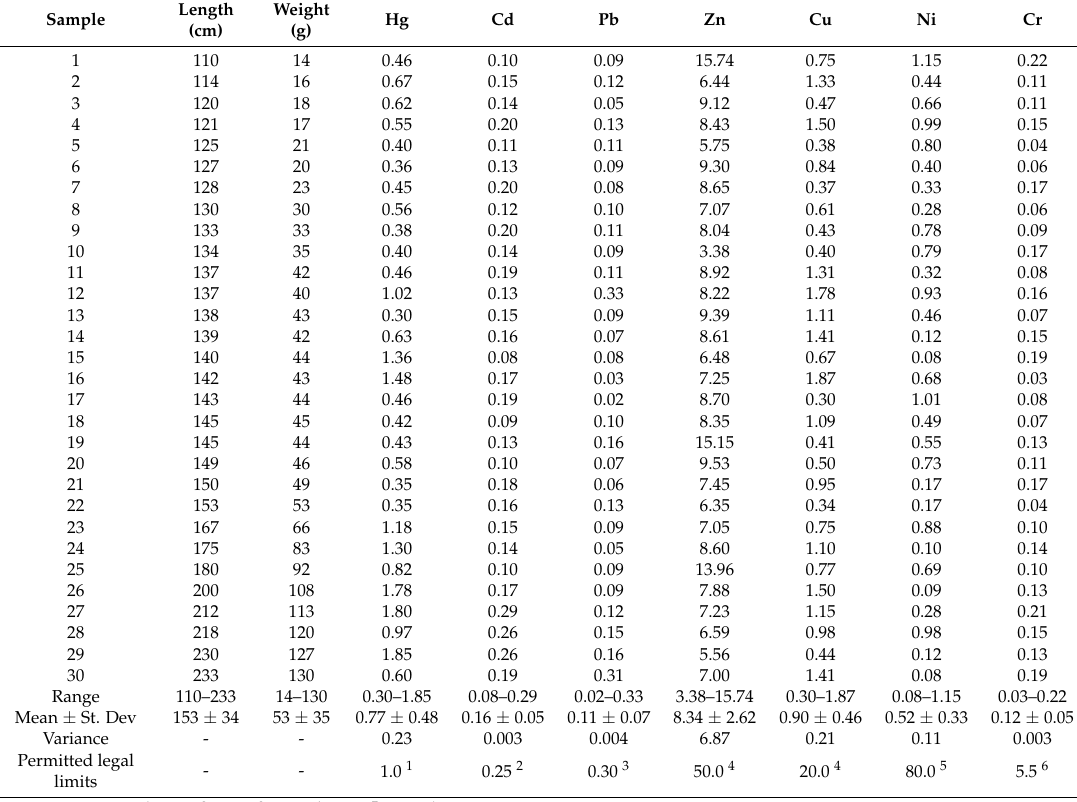
Table 1. Biometric data, metal concentrations ( µ g g − 1 wet weight) (range, mean ± standard deviation, variance) and permitted legal